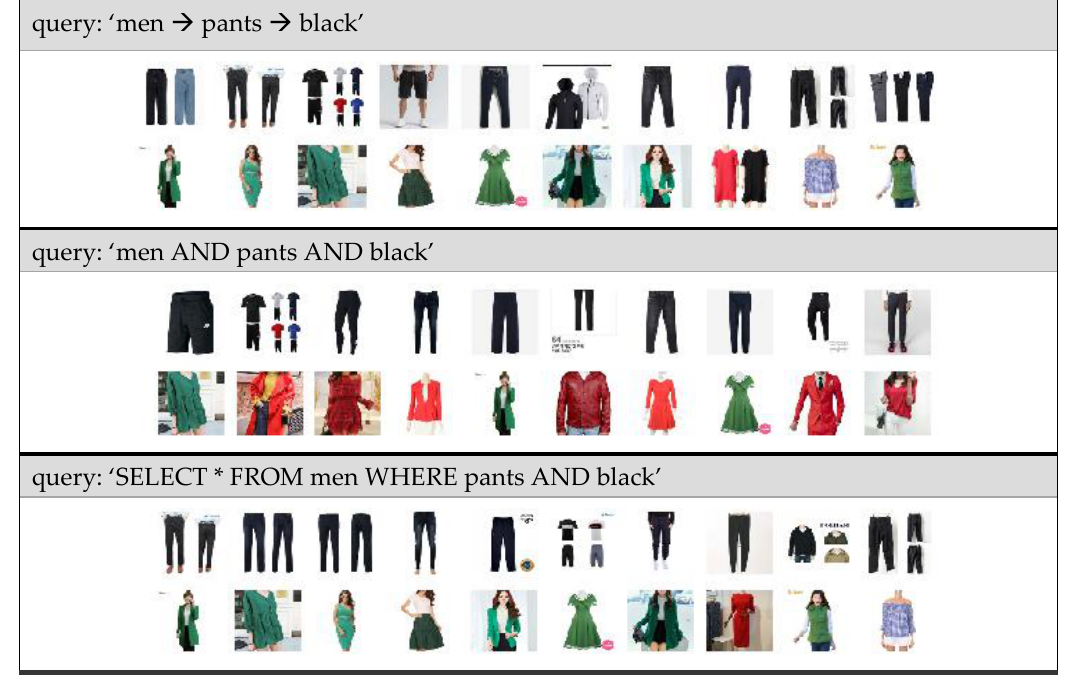
Figure 12. Search results for three different types of queries with similar or the same meaning. query: ‘men coat AND shirt’